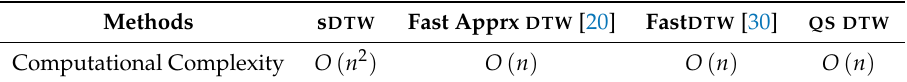
Figure 5. Computation time for computing the cut specific principal alignments for all the datasets. It includes the computation of cut specific principal alignments for all the frequent classes over all the cut portions. Table 9. Computational complexities of DTW -based methods for distance computation. Here n is the length of the cut-portion of the feature